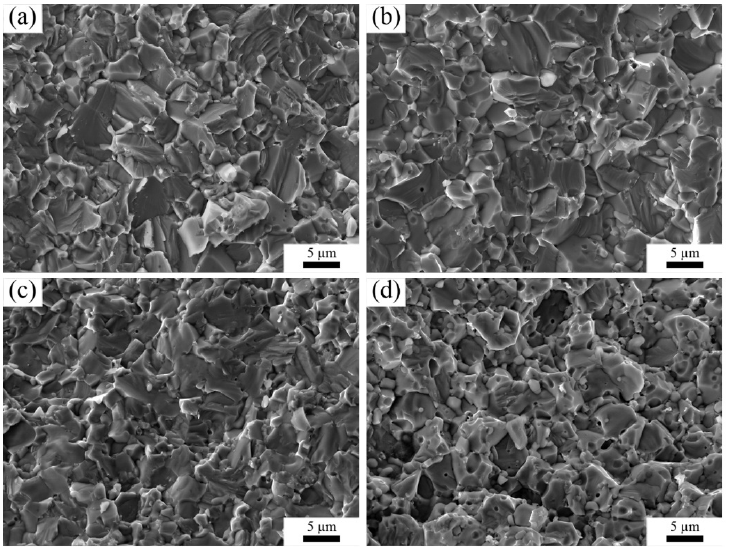
Figure 5. Scanning electron microscopy (SEM) images of the fractured surface of the sintered sam- ples. ( a ) ZN, ( b ) ZT10, ( c ) ZT20, ( d )